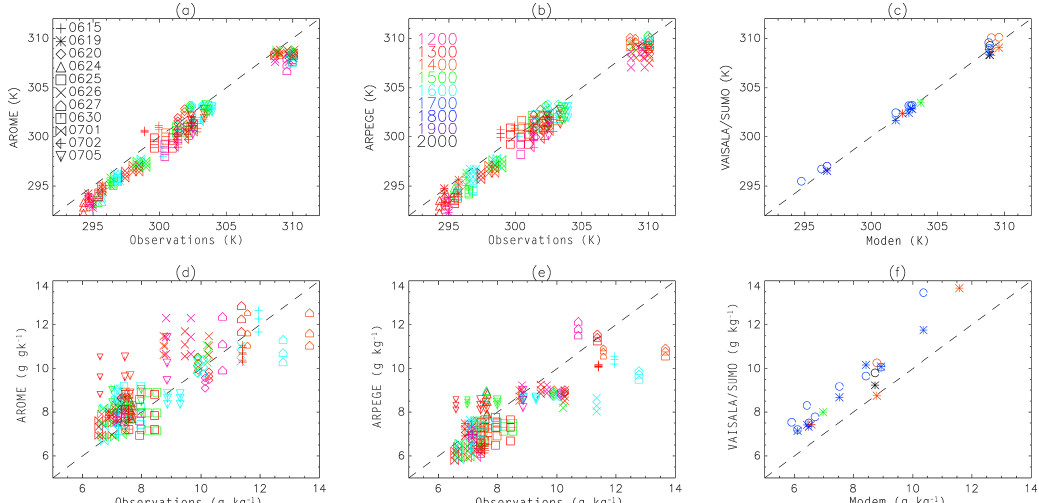
Figure 6. Scatter plot for (a, b, c) the potential temperature and (d, e, f) the water vapour mixing ratio averaged over the first 500m deep layer: (a, d) AROME values vs. the observed values, (b, e) ARPEGE values vs. the observation values and (c, f) values obtained from the Vaisala and the SUMO profiles vs. the values obtained from the MODEM profiles. Symbols vary from one day to the other and colour from one time to the other (see